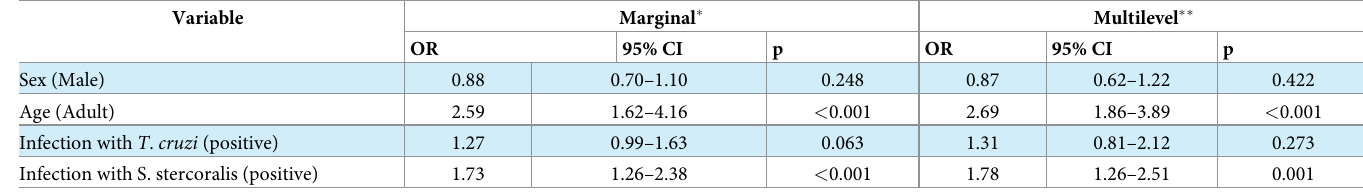
Table 4. Marginal and multilevel logistic regression that describes associations between anemia and age, sex, and infection with S . stercoralis and T . cruzi . Variable